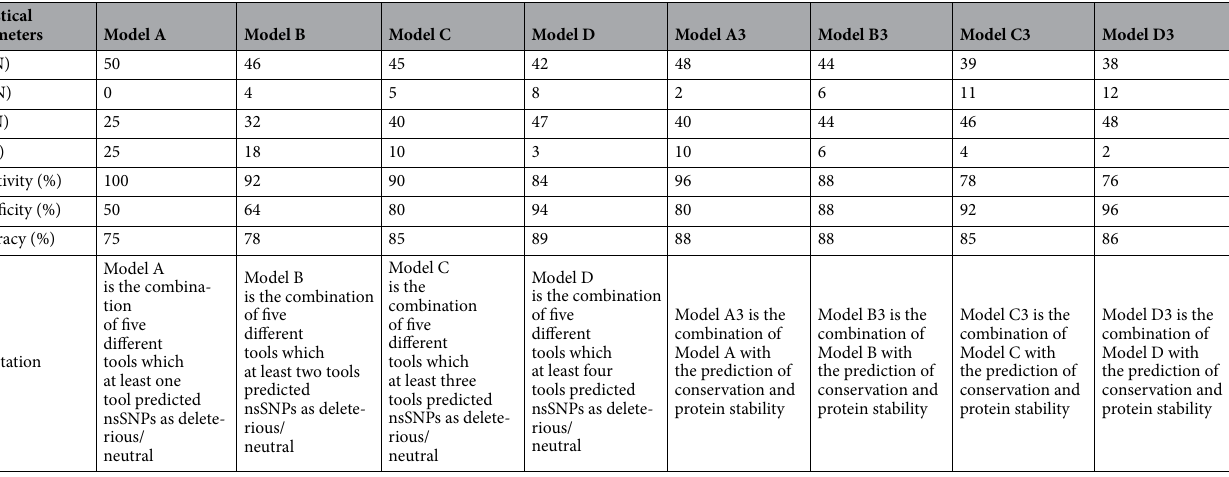
Table 2. Performance of 8 different prediction models (Model A, B, C, D, A3, B3, C3 and D3) using functional effect prediction tools (SIFT, PolyPhen-2, Condel, PROVEAN, and PANTHER) and conservation (Consurf) and protein stability (I-Mutant). The prediction tools’ performance was assessed on a standard dataset with all statistical parameters; TP, FN, TN, FP, sensitivity, specificity, and accuracy. TP = True Positive; FN = False Negative, TN = True Negative and, FP = False